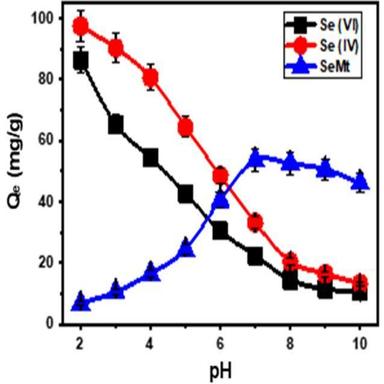
Effect of pH on the adsorption of the different selenium species by CF/ZA composite.